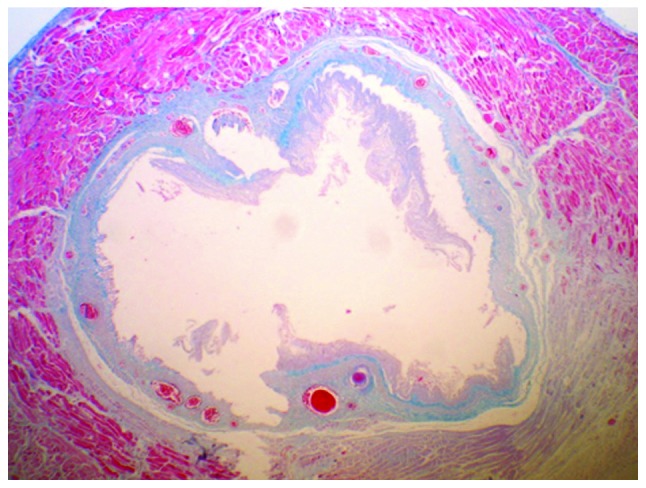
Widespread collagen accumulation was observed in the submucosal and muscular layers in the burn group (magnification, ×100; staining, hematoxylin-eosin and Masson’s trichrome).